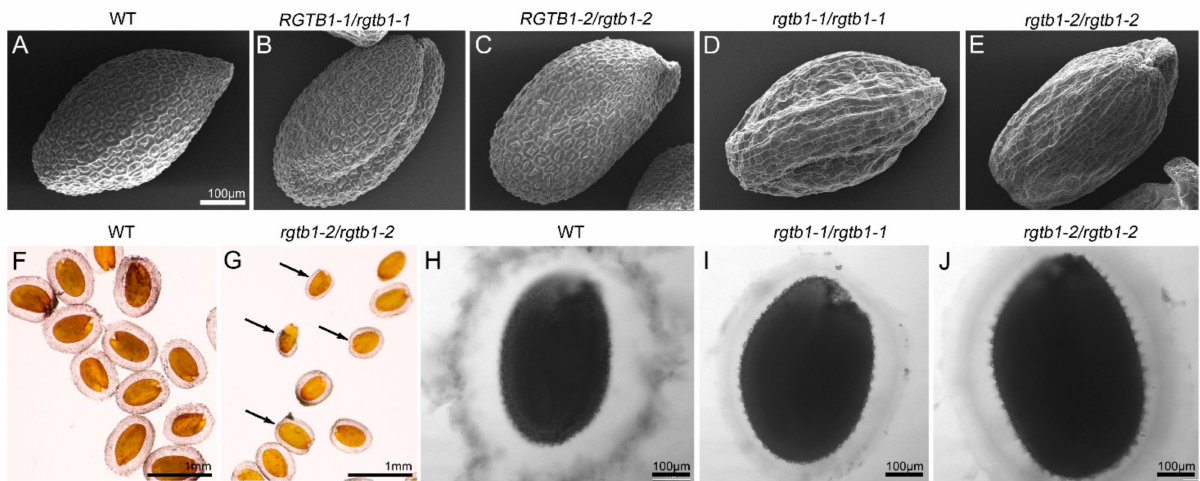
Figure 9. Seed coat formation is affected in rgtb1 plants. The seed coat of WT seeds ( A ) and seeds formed on RGTB1 / rgtb1 self-crossed plants ( B,C ) appear similar. However, rgtb1 -derived seed coats consist of cells of uneven shape that do not contain mucilage pockets ( D – E ). SEM images, scale bar 100 µ m, correspond to ( A – E ). After imbibition, seeds formed on WT plants exude large amounts of a mucilage sheath ( F , H ), but rgtb1 -derived seeds form a more compact and uneven mucilage sheath ( G , I , J ). Scale bar 1 mm for images ( F , G ); scale bar 100 µ m for images ( H – J ); ( F – J ) microscopic images of seeds stained with ruthenium red. Black arrows in ( G ) point to the seeds forming uneven or no mucilage